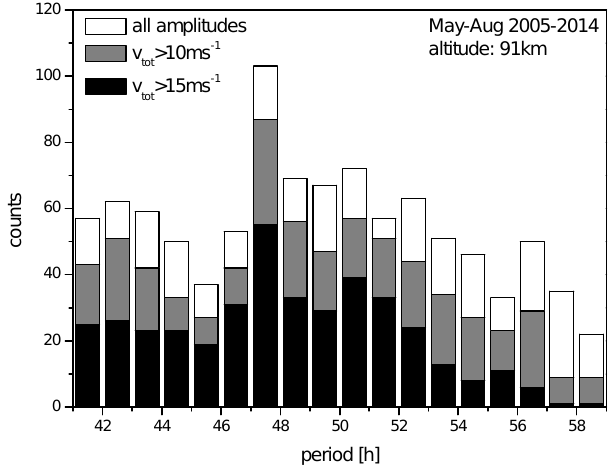
Figure 4. Distribution of QTDW periods in summer (May–Aug) for the years 2005–2014. Black: amplitudes larger 15ms − 1 only. Gray: amplitudes between 10 and 15ms − 1 . White: amplitudes smaller than 10ms − 1